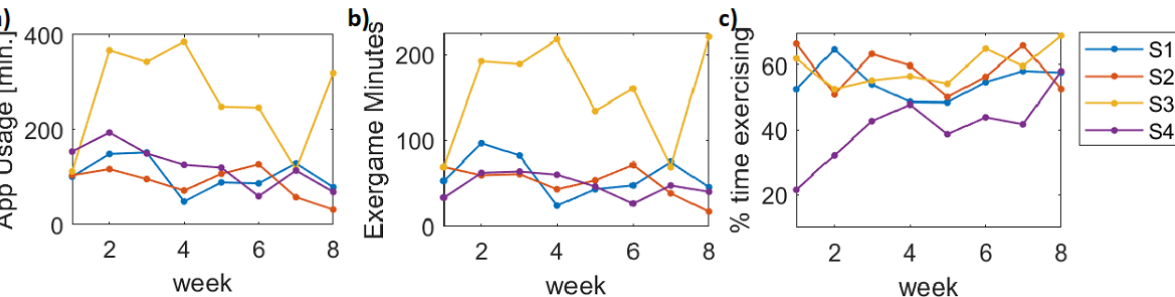
Figure 10. WOW-Mobile app usage over the 8-week period. (a) Total number of minutes spent on the app. (b) Number of minutes spent in exergaming sessions on the app. (c) Percent time on app spent exergaming.